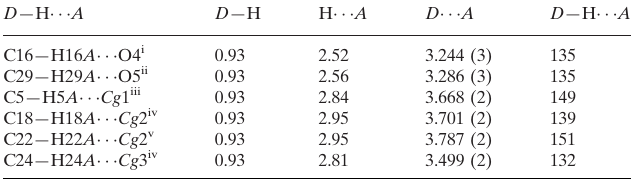
Hydrogen-bond geometry (A˚ , (cid:2)